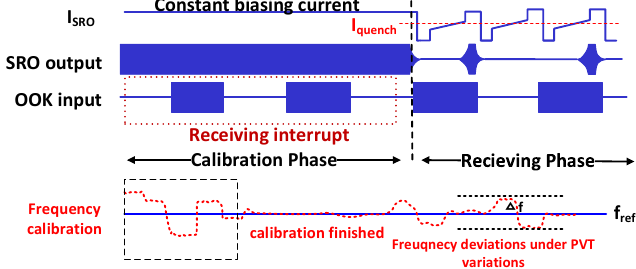
Figure 2. The timing diagram of the conventional frequency calibration.